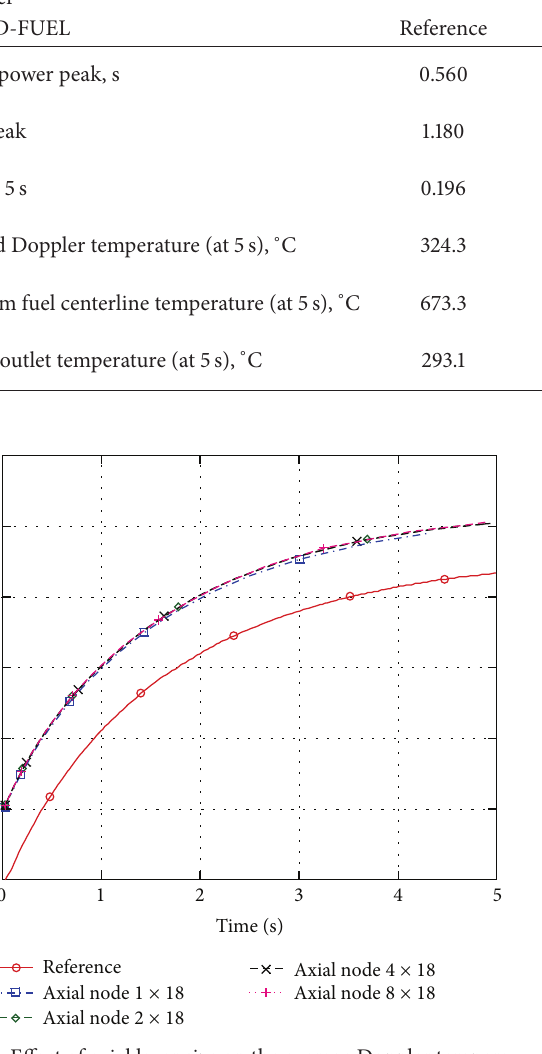
Figure 10: Effect of the axial layer size on the average Doppler temperature for case